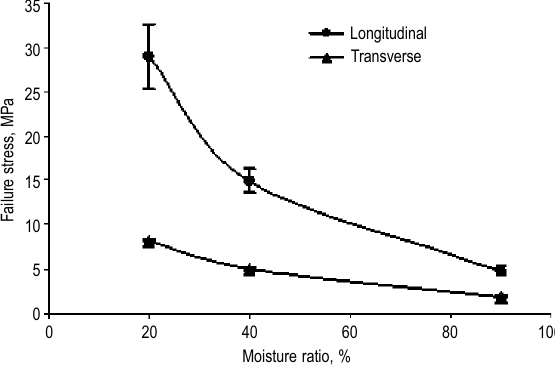
cracksFig. 10. Failure stress variation according to moisture ratio